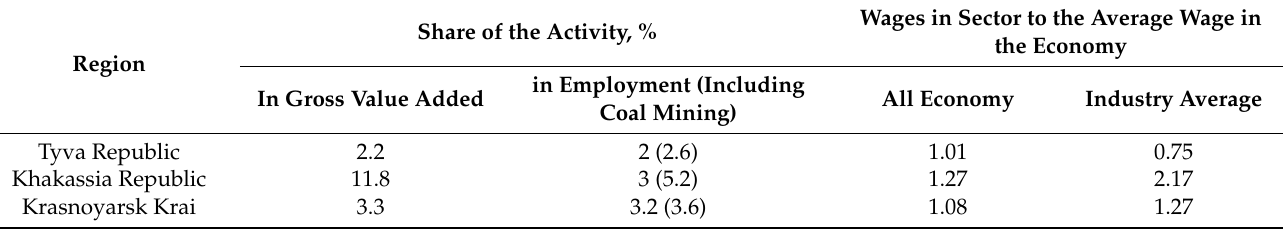
Table 7. Contribution of electricity, gas and steam supply, and air conditioning in the gross value added and employment of the regions of Yenisei, Siberia, 2020. Source: Rosstat data. Wages in Sector to the Average Wage in Share of the Activity, % the Economy Region in Employment (Including In Gross Value Added All Economy Industry Coal Mining)